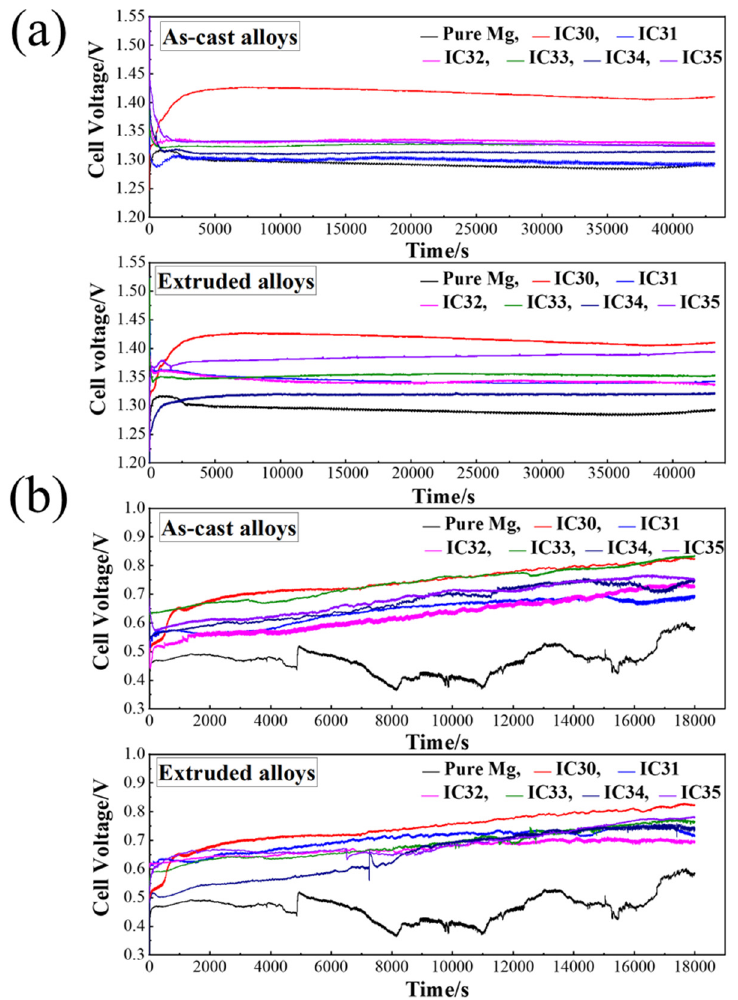
Figure 4. Galvanostatic discharge curve of pure Mg and Mg-In-Ca alloys at ( a ) 2.5 mA · cm − 2 discharge current for 12 h and ( b ) 30 mA · cm − 2 discharge current for 5